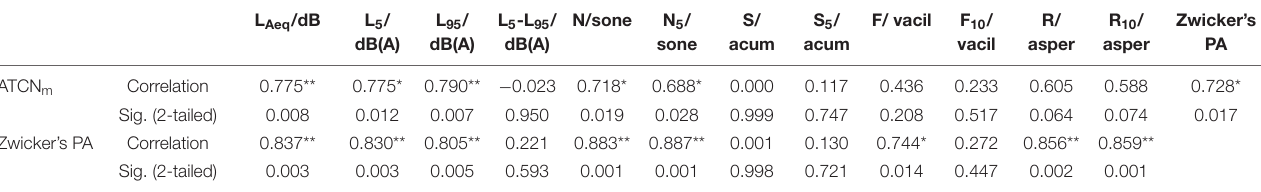
TABLE 8 | Correlation between ATCNm and Zwicker’s PA and typical noise acoustic